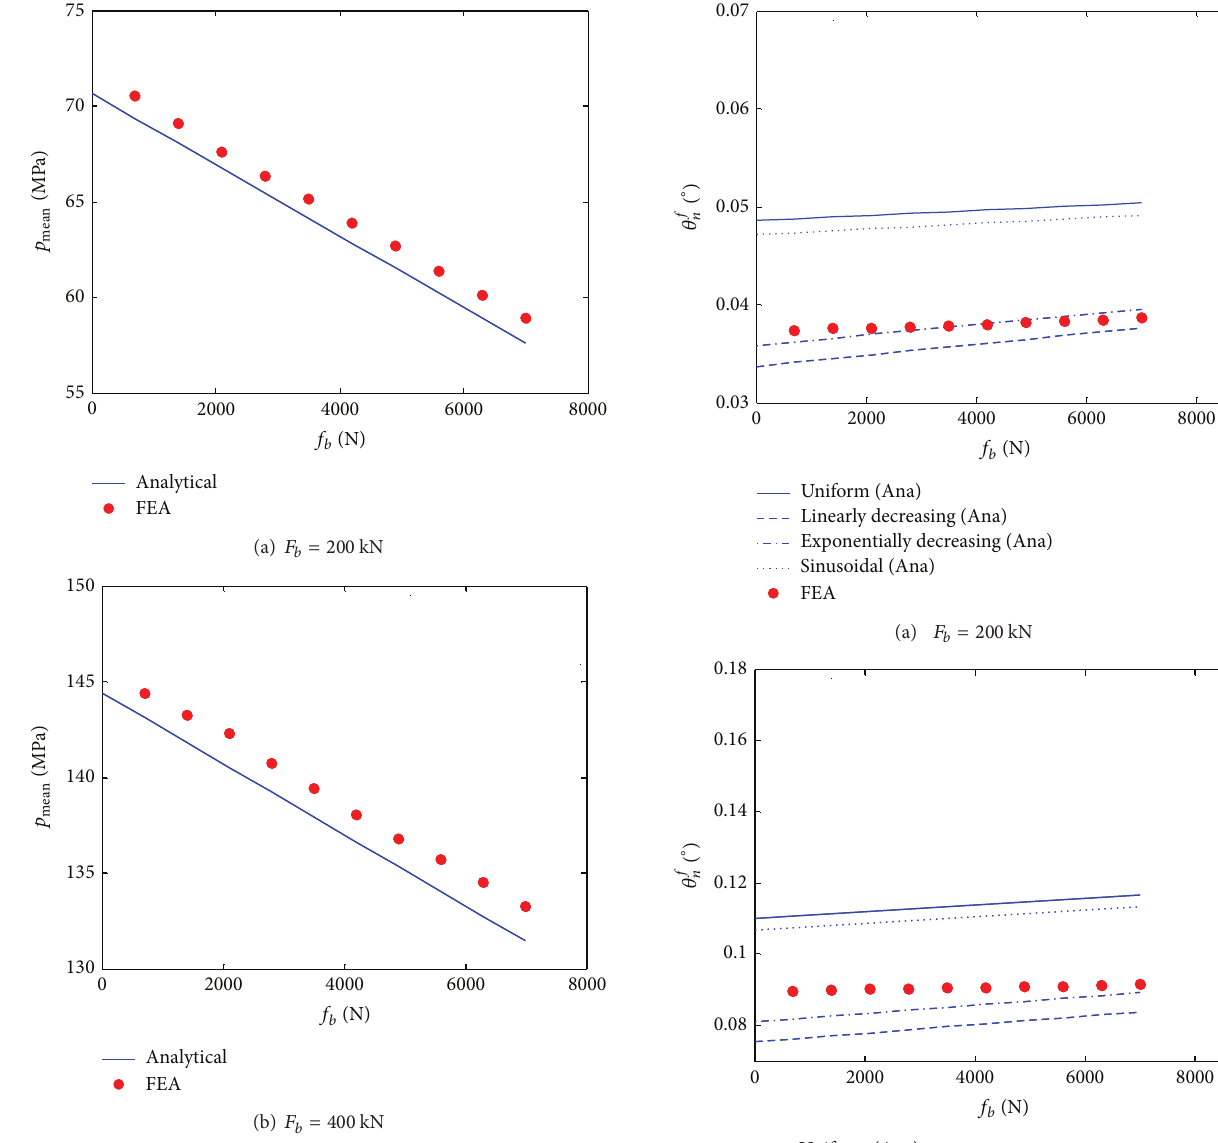
Figure 6: Average value of the underhead contact pressure under different locking force.